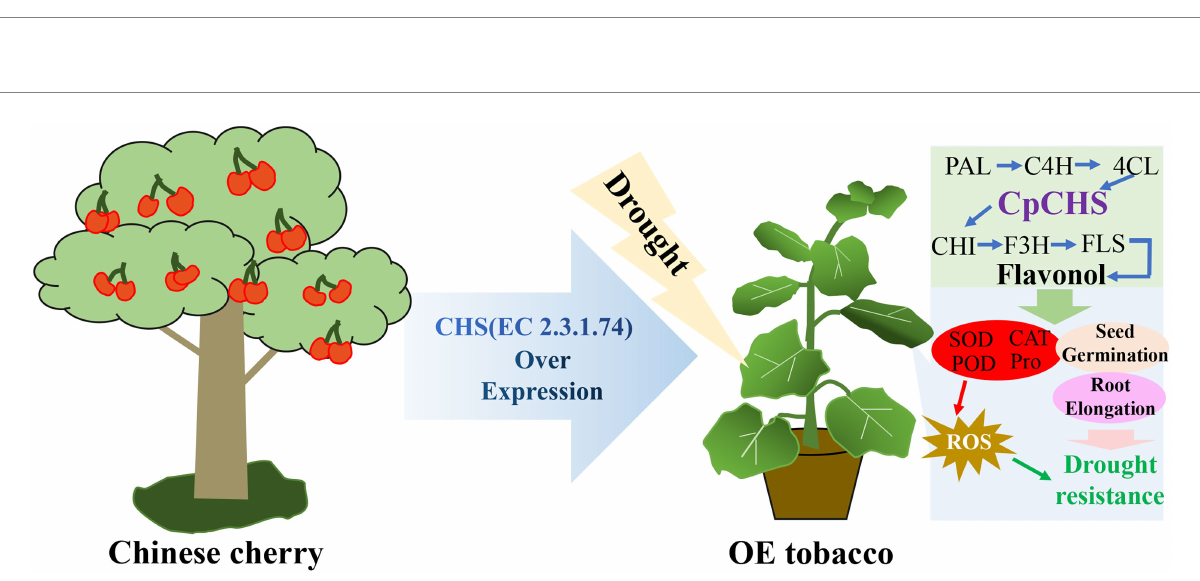
FIGURE 7 A possible model of CpCHS1 responding to drought stress in the transgenic of tobacco. CpCHS1 induced changes in related genes in the flavonol biosynthesis pathway under drought stress, increased SOD, POD, CAT, and Pro contents, and scavenged ROS accumulated in drought stress. In addition, the germination rate and root length of tobacco in a dehydrated environment are increased, and finally, the purpose of drought resistance is